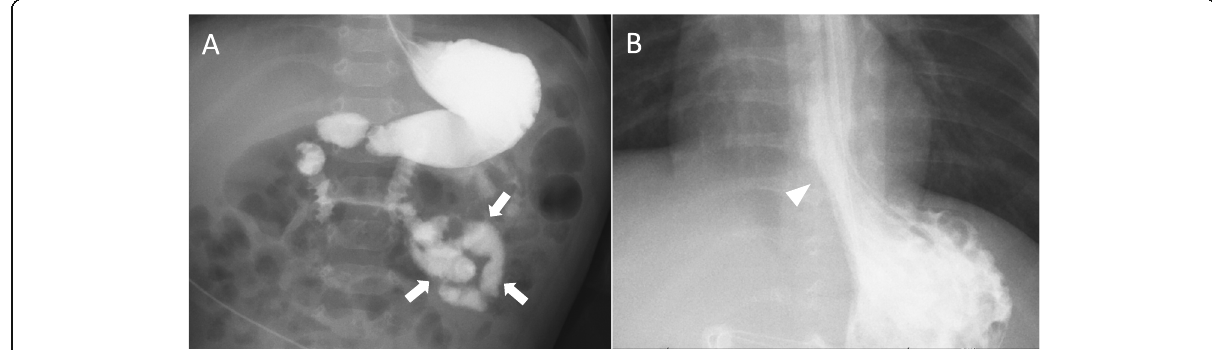
Fig. 1 Gastrointestinal phenotypes associated with Pierson syndrome. a An upper gastrointestinal contrast study depicting the intestinal malrotation. Arrows indicate the “ corkscrew sign ” of the proximal jejunum. b A radiographic contrast image depicting the gatroesophageal reflux (arrow